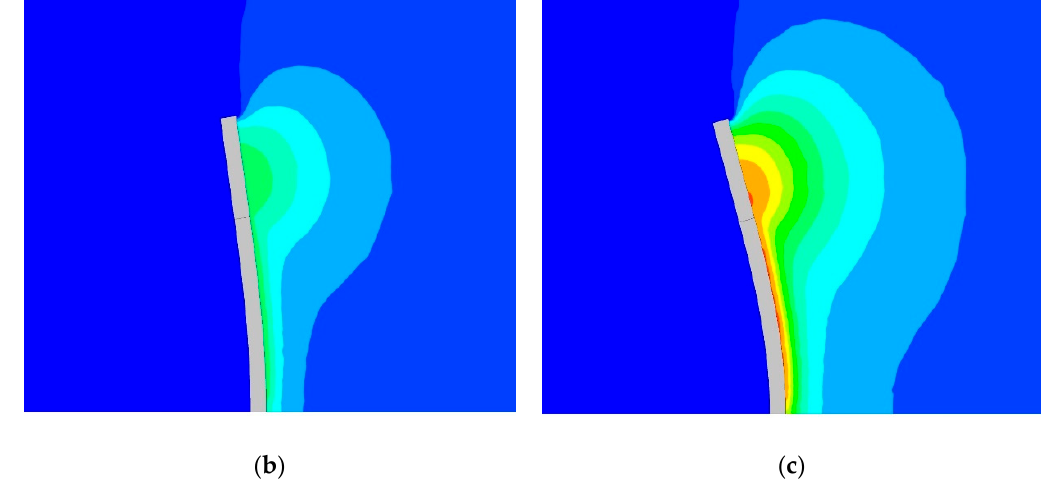
Figure 15. Pressure distribution (Pa) of T-shaped flexible beam at t = 10 s ( a ) Re = 25,500, ( b ) Re = 42,500, and ( c ) Re = 59,500.